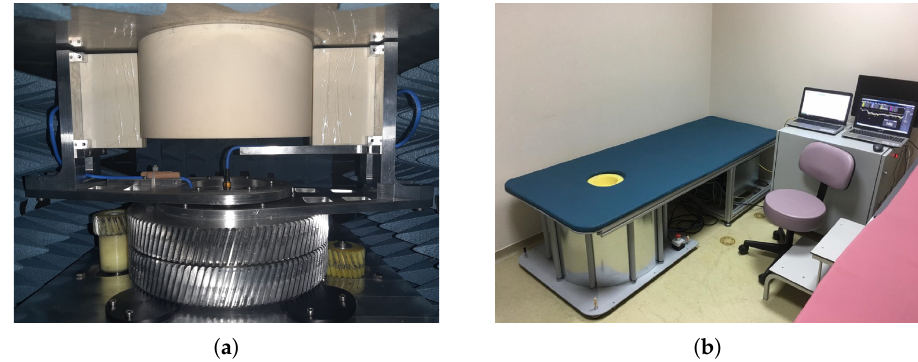
Figure 1. SAFE (Scan and Find Early) scanning configuration and bed system: ( a ) mehanically mobile bistatic system producing 1296 measurements for each frequency employed and ( b ) the SAFE design in a clinical